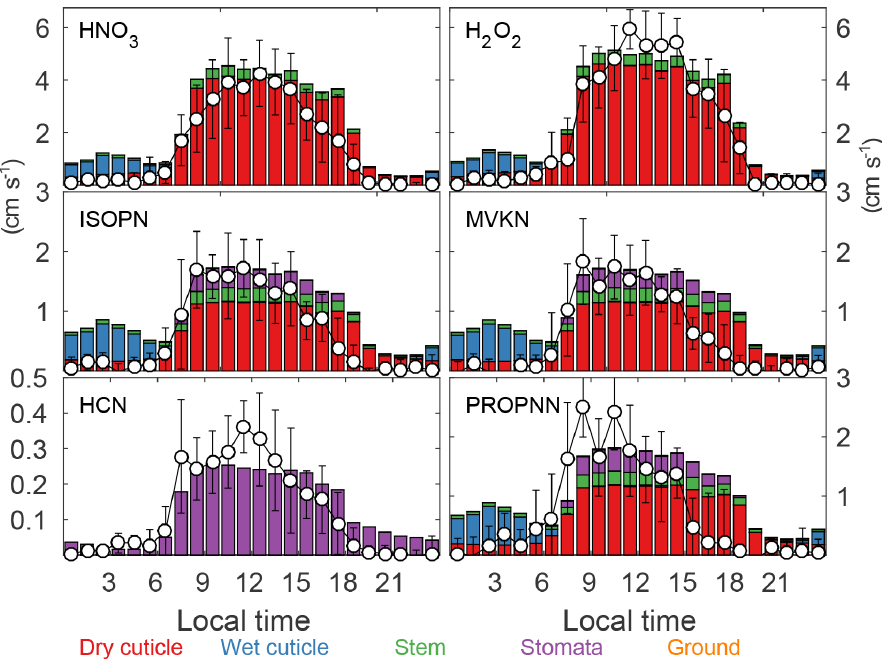
Figure 4. Observed (circles ± standard deviation) and simulated (bars) dry deposition velocities for several nitrogen-containing species and hydrogen peroxide over the Talladega National Forest (southeastern US) in June 2013 (5 days; Nguyen et al., 2015). The bar colors indicate the contribution of the different surfaces to the overall surface removal of the chemical tracer.